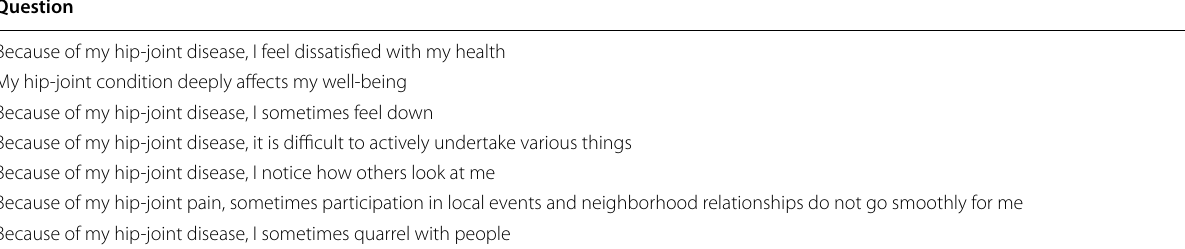
JHEQ: Japanese Orthopedic Association Hip Disease Evaluation Questionnaire